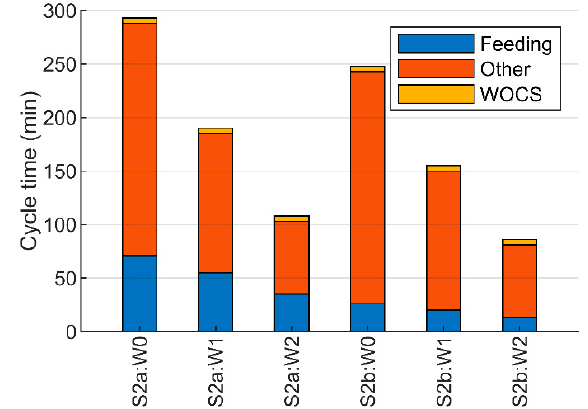
Figure 12. Estimated robot winding cycle time results for complete S2a–b stators in winding devel- opment scenarios W0–2, divided into feeding time, other time and WOCS time.